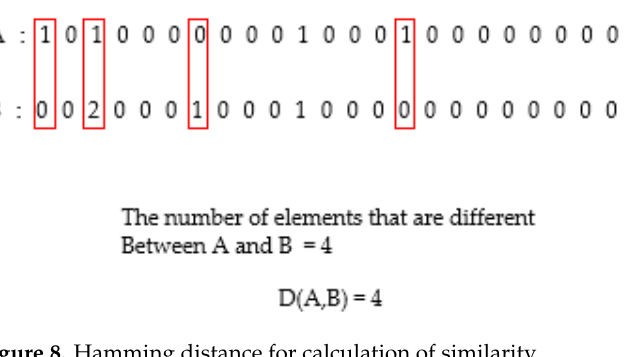
Figure 8. Hamming distance for calculation of similarity.